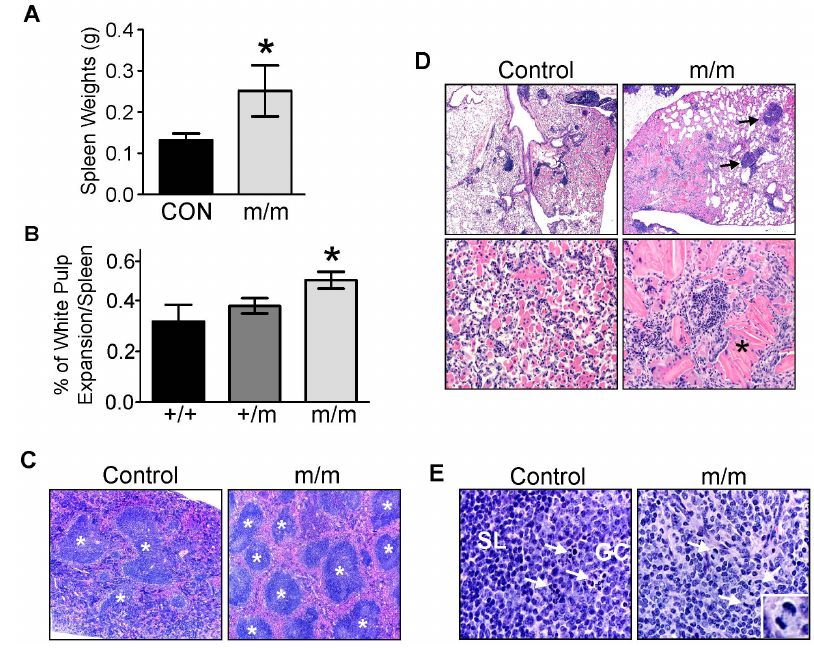
Figure 5. Loss of NIAM promotes reactive lymphoid hyperplasia and B-cell lymphoma in the spleen. A . Weights of spleens from + / + and + /m mice (CON, n=15) compared to NIAM m/m mice (m/m, n=12). Note: one WT ( + / + ) mouse with an incidental case of severe chronic pyometra was excluded from the analysis. Statistical significance was shown by a Mann-Whitney test (*, p , 0.05) B . The percentage of splenic white pulp per total splenic area was calculated for each genotype. NIAM m/m mice (n=8) are statistically different from both wild-type ( + / + , n=5) and heterozygous ( + /m, n=6) mice as calculated by an unpaired two-tailed T-test. (*, p , 0.05) Note: one WT ( + / + ) and one mutant (m/m) mouse were excluded from the analysis because extensive extramedullary hematopoiesis prevented accurate visualization of the white pulp C . Representative images of spleens from control wild-type ( + / + ) and homozygous m/m mice (H&E, 40x). Splenic white pulp (asterisks) was increased in NIAM m/m mice. Note: these samples show a range of variation in the extent of red pulp extramedullary hematopoiesis that was seen for both groups. D . Eosinophilic crystalline pneumonia in the lungs of control NIAM + /m heterozygous and NIAM m/m mice. Loss of NIAM resulted in more severe disease with extensive pulmonary lymphoid inflammation (arrows) and large extracellular crystals (asterisks) in the affected NIAM m/m mouse. (H&E, 40 6 top and 100 6 bottom panels) E . White pulp from control NIAM + /m heterozygous and NIAM m/m homozygous mice (H&E, 600x). A spleen from a heterozygous mouse with chronic ulcerative dermatitis and reactive hyperplasia of white pulp characterized by a germinal center (GC) and tingible body macrophages full of cellular debris (arrows) on a background of small lymphocytes (SL) (left panel). In two homozygous m/m mice, typical white pulp architecture was multifocally depleted and effaced by centroblasts and centrocytes with multiple mitotic figures (inset and arrows) (right panel). Note that NIAM + /m heterozygous and NIAM + / + wild-type mice appeared identical in our analyses and were therefore used interchangeably as controls.